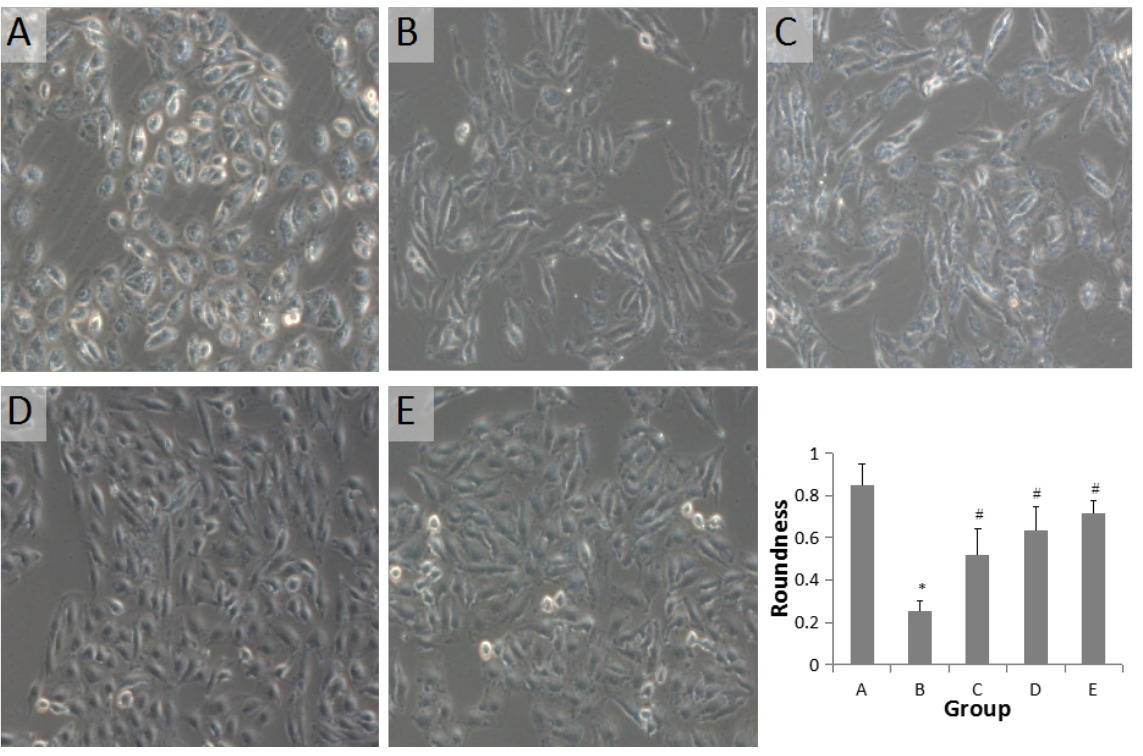
Figure 1: Changes in the morphology and roundness values of A549 cells stimulated by different concentrations of GLXB-D drug serum and TGF-β1 for 24h (×200). (A): control group; (B): 5ng/mL TGF-β1 induced group; (C): 5% GLXB-D drug serum group; (D): 10% GLXB-D drug serum group; (E): 15% GLXB-D drug serum group. Comparison with control group: * P< 0.05; comparison with the TGF-β1 induced group: # P<